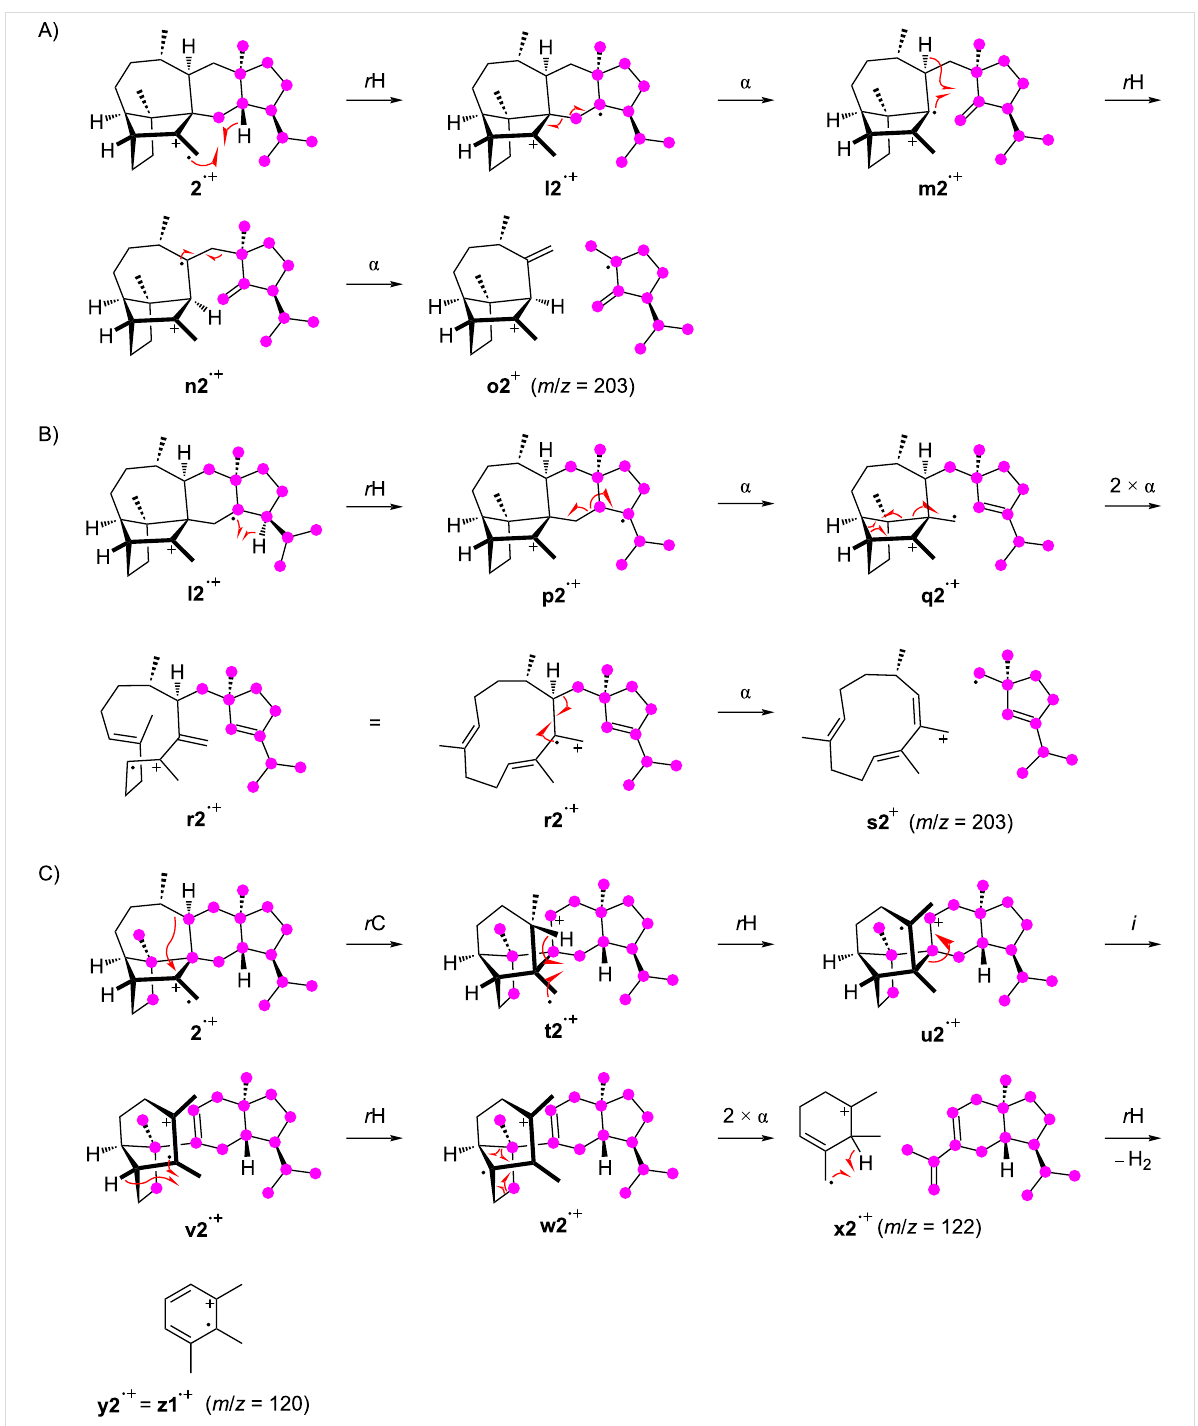
Scheme 4: The EIMS fragmentation mechanisms for 2 explaining the formation of the fragment ions at m / z = 203 and 120. Lost carbons are marked by purple